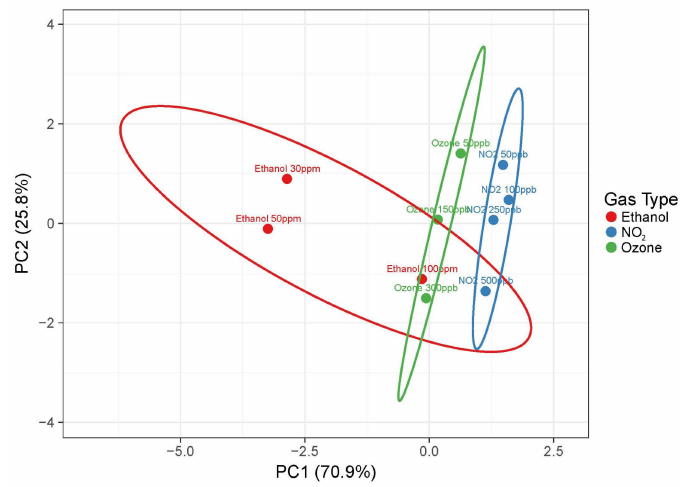
Figure 9. Pareto scaling was applied to rows; singular value decomposition (SVD) with imputation was used to calculate principal components. X and Y axis show principal component 1 and principal component 2 that explained 70.9% and 25.8% of the total variance, respectively. Prediction ellipses are such that with probability 0.95, a new observation from the same group falls inside the ellipse. N = 10 data